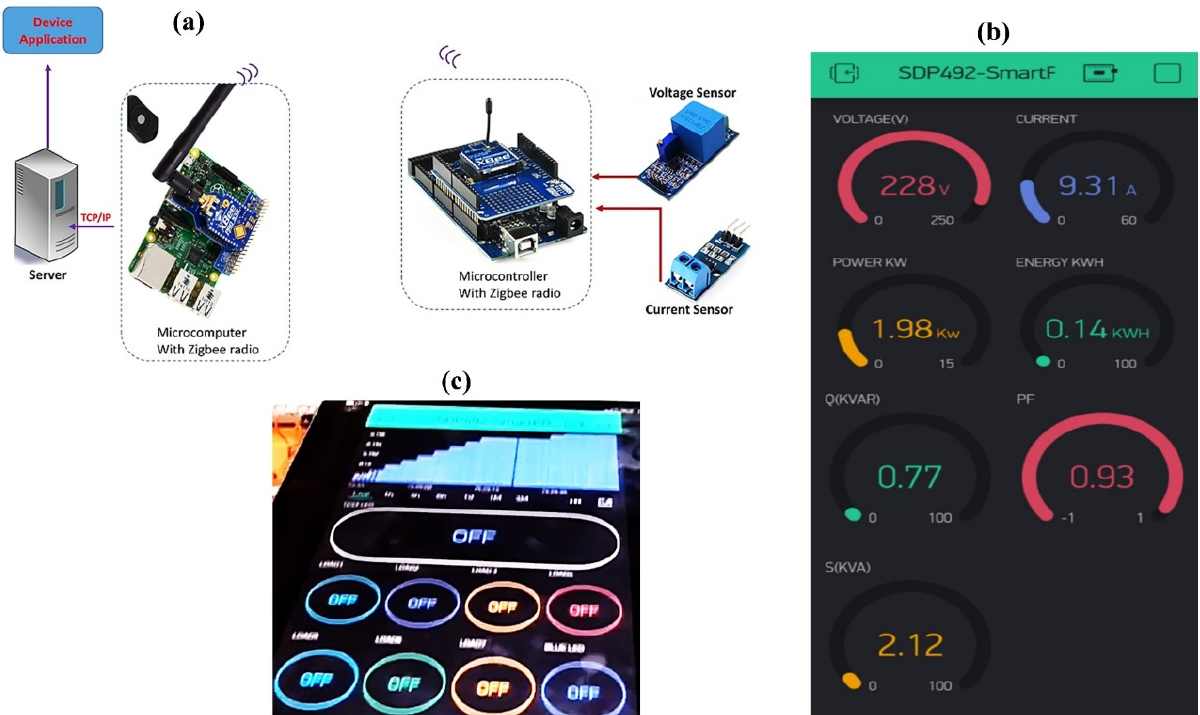
Figure 11. ( a ) Prototype design of smart power meter based on ZigBee communication protocol, ( b ) display dashboard, and ( c ) appliances remote control using Blynk IoT platform.